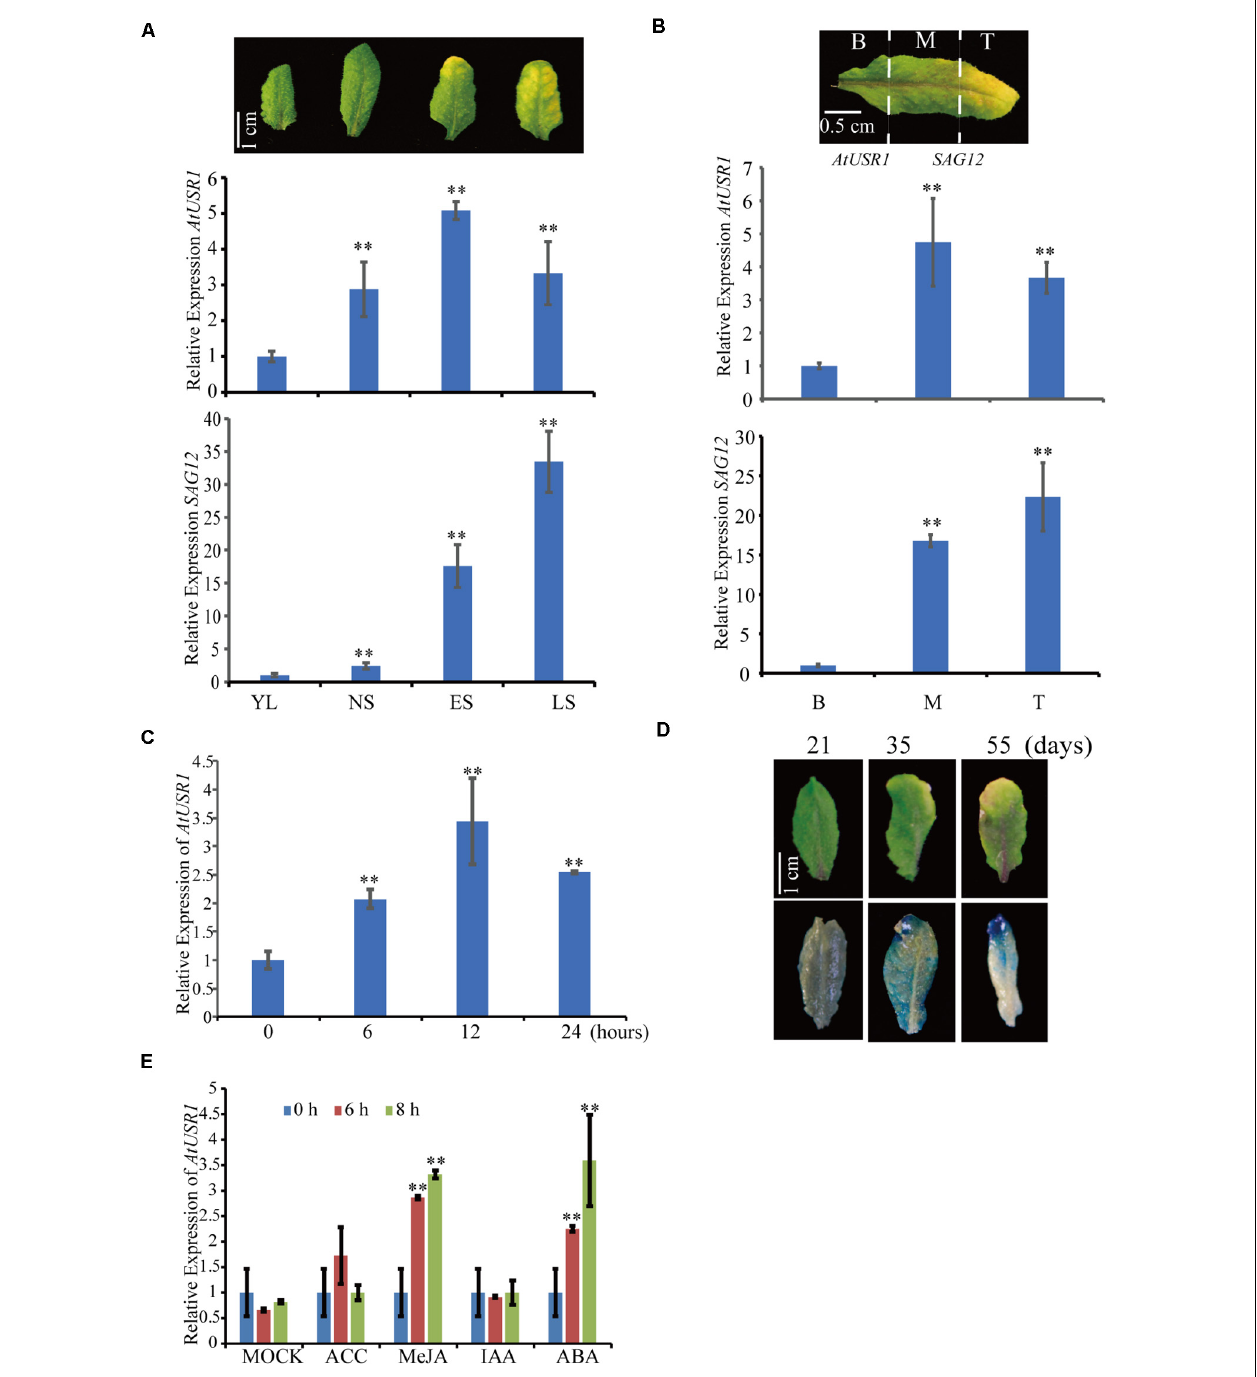
FIGURE 1 | The expression pattern of AtUSR1 . (A) The transcript level of AtUSR1 was enhanced in an age dependent manner and reached its peak at the ES stage. According to the description of Guo and Gan (2006), gene expression was detected at four different stages of leaf senescence in Arabidopsis. YL, young leaves; NS, fully expanded mature leaves without senescence symptoms; ES, early senescent leaves; and LS, late senescent leaves. The relative values of gene expression ( AtUSR1 and SAG12 ) were calculated based on comparison with gene expression from YL, which was set as 1. (B) The expression pattern of AtUSR1 in indifferent parts of a yellowing leaf; B, Base; M, Middle; and T, Tip. (C) The expression pattern of AtUSR1 under dark conditions. The relative values of gene expression were calculated based on comparison with gene expression from B , which was set as 1. (D) Histochemical staining of GUS activity detection in leaves at different timepoints as indicated. (E) The expression of AtUSR1 was induced by MeJA and ABA treatments. * and ** indicate significant difference at 0.01 < P < 0.05 and P < 0.01 levels using student’s t -test. Data are shown as the mean ± SD from three independent experiments. Significance analysis was only performed on AtUSR1